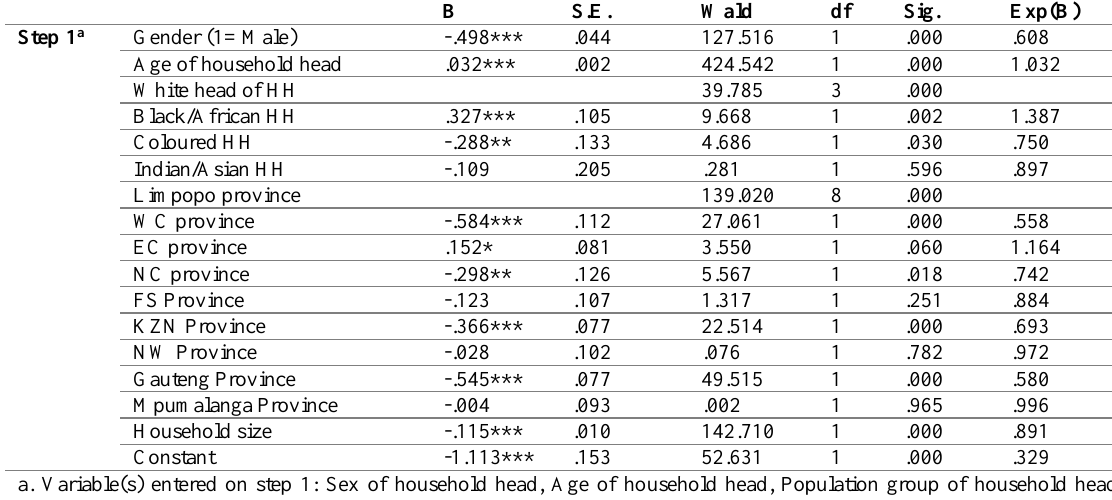
Table 3: Logistic regression